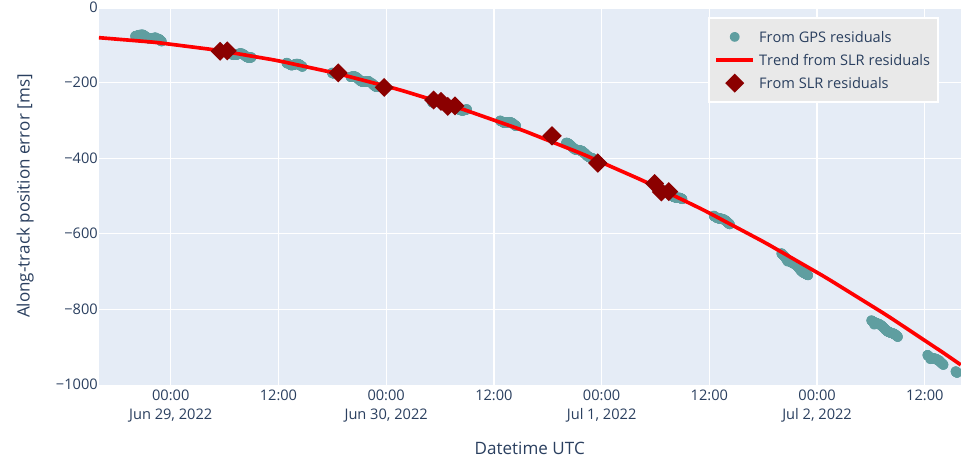
Figure 12. Evolution of time bias of TUB17901 CPF orbit prediction generated on 28 June 2022. Teal represents time bias computed from GPS measurements, dark red represents time bias from SLR data (from GFZ website), and the red line represents the polynomial fit from SLR time bias to predict the time bias trend (from GFZ